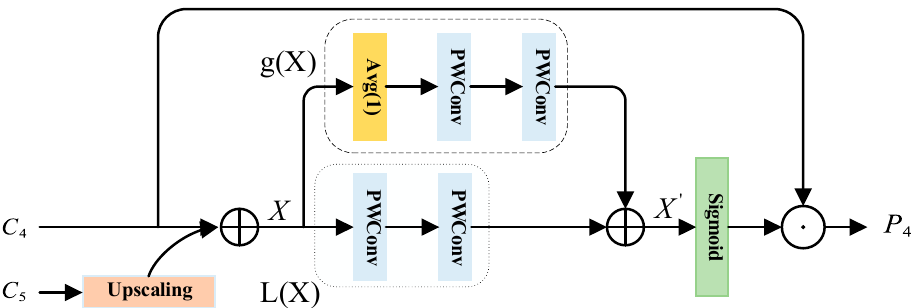
Figure 3. Structure design of two-branch attention feature fusion (TB-AFF) module.